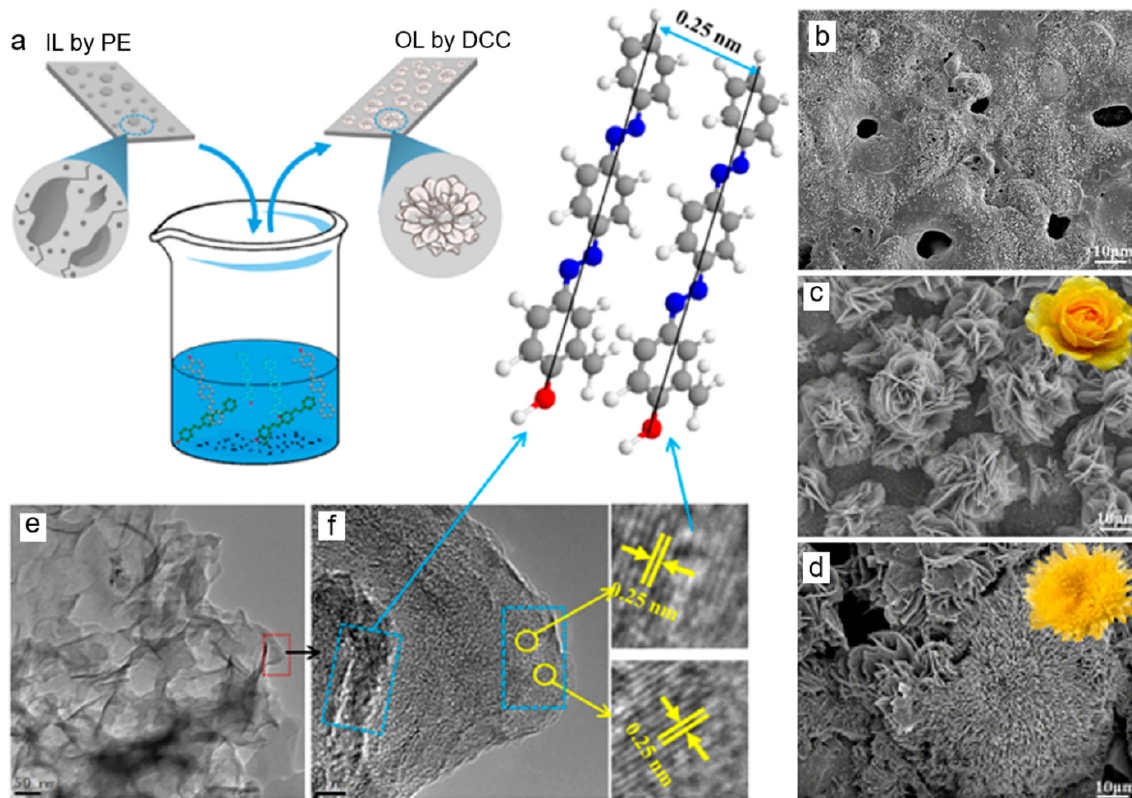
Figure 1. Fabrication of HOI material on AZ31 Mg surface showing a schematic illustration ( a ) describing IL ( b ) subjected to DCC containing PPC molecules with different concentration of 1 M ( c ) and 2 M ( d ). A representative TEM ( e ) and HR-TEM ( f ) images of flower petals. Reproduced with permission from [13]. Copyright © 2018 American Chemical Society.